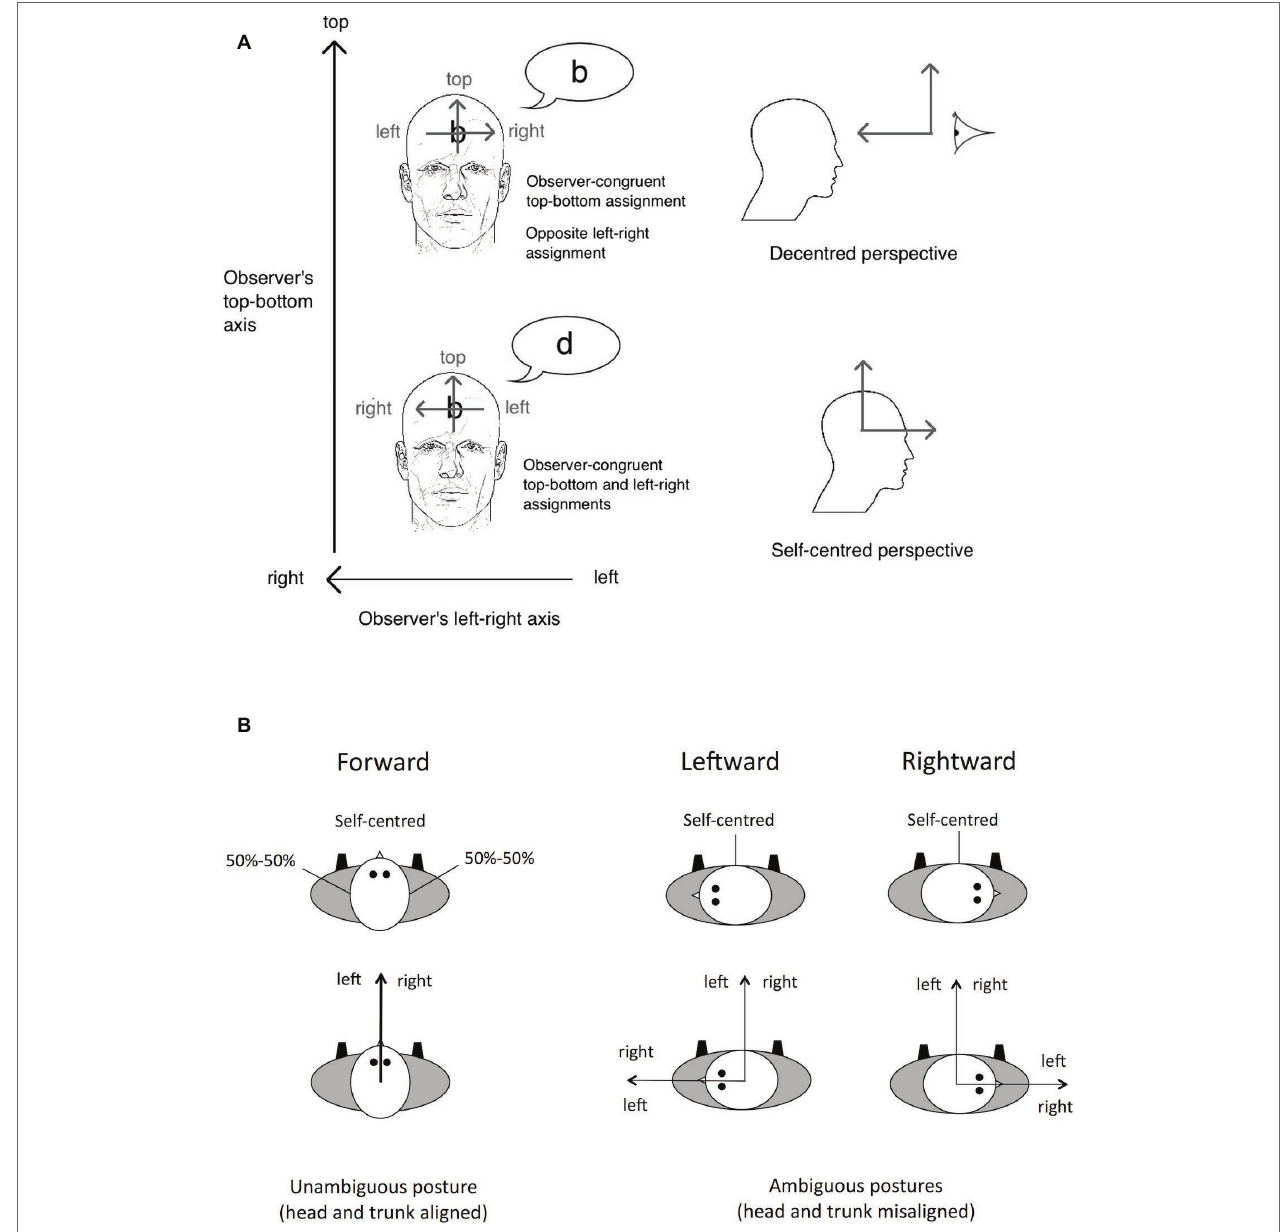
FIGURE 2 | Illustration of the spatial perspectives – self-centered versus decentered – that can be adopted in the graphesthesia task. (A) When the letter is drawn on the participants’ forehead, some participants perceive the letter “b,” assigning the left-right axis of the letter in the direction opposite to their own head’s left-right axis. This assignment may result from a decentered perspective whose origin is in front of the participant’s head. Other participants will perceive the mirror-reversed letter “d” instead, assigning the left-right axis of the letter in the same direction as their own head’s left-right axis. This assignment may result from a self-centered perspective whose origin is located inside the head. Source: Arnold et al., 2017. (B) Illustration of the results reported by Natsoulas and Dubanovski (1964) showing that the adoption of self-centered versus decentered perspectives on the sides of the head depends on the orientation of the head in yaw relative to the trunk. With an ambiguous posture (head and trunk misaligned), the left-right axis of the observer’s egocentric reference frame may be assigned with respect to the head or the trunk. When a tactile letter is drawn on the side of the head, with such an ambiguous posture, the left-right axis of the letter is assigned with respect to the trunk. Figure 2A is reprinted from Consciousness and Cognition 56. Arnold, G., Spence, C., and Auvray,